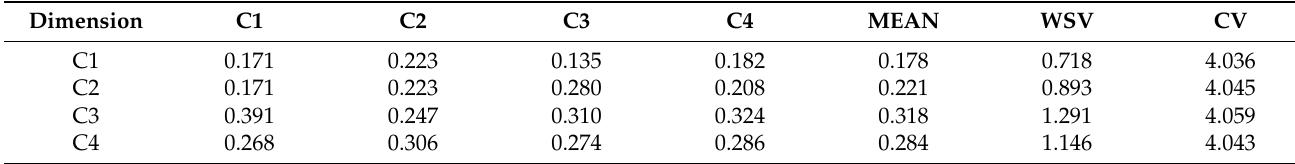
Table 8. The normalized comparison matrix of